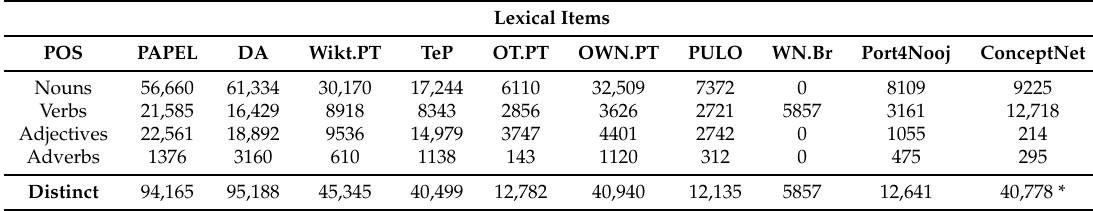
Table 2. Number of lexical items extracted from each LKB.